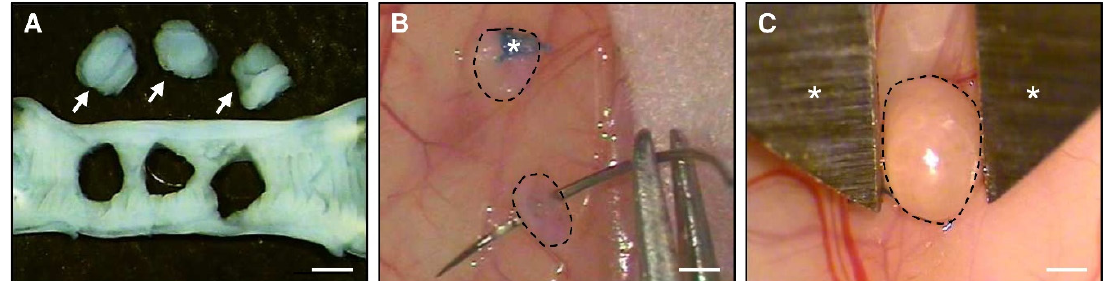
Figure 1. ( A ): Longitudinally opened uterine horn of a donor BALB/c mouse. Three uterine tissue samples (arrows) were excised by means of a 2-mm dermal biopsy punch. ( B ): Fixation with a Prolene suture (asterisk) of uterine tissue samples (borders marked by broken lines) to the peritoneal wall of a recipient BALB/c mouse for the induction of endometriotic lesions. ( C ): Two-dimensional measurement of the size of an endometriotic lesion (border marked by broken line) by means of a digital caliper (asterisks) 28 days after transplantation of an uterine tissue sample to the abdominal wall of a recipient BALB/c mouse. Scale bars: ( A ), ( B ) = 1.8 mm; ( C ) = 1 mm.